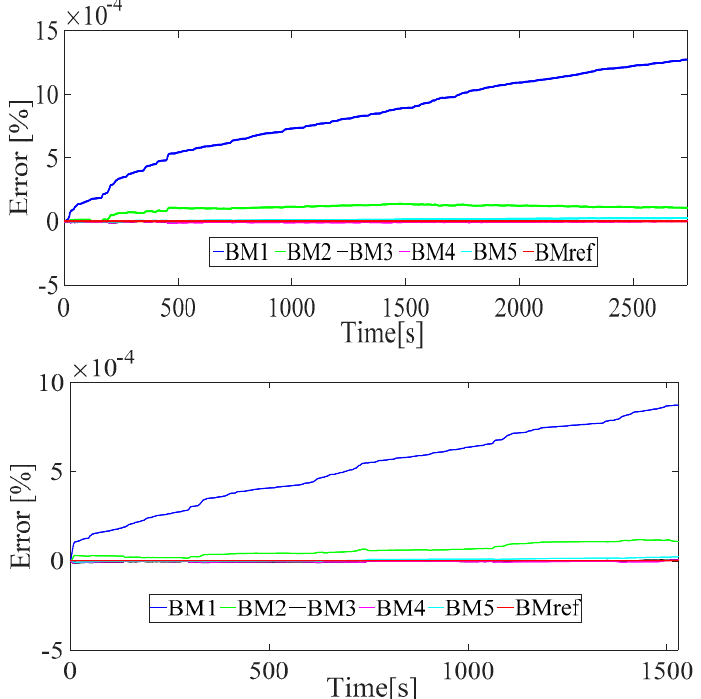
Figure 9. Error between the battery capacity fade computed by the MPC model and the reference vehicle during 2 UDDS ( up ) and HWFET ( down ) drive cycles.